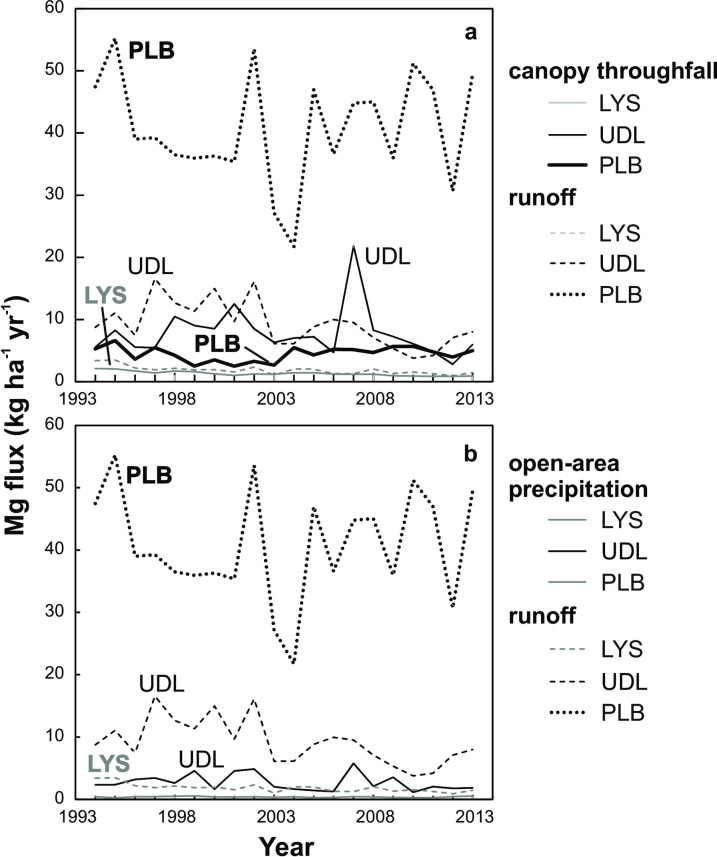
Time-series of annual Mg input–output fluxes.